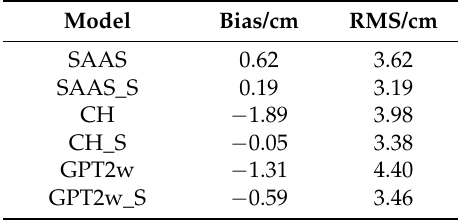
Table 2. Statistical results of the mean accuracy using radiosonde data for 2013. Model